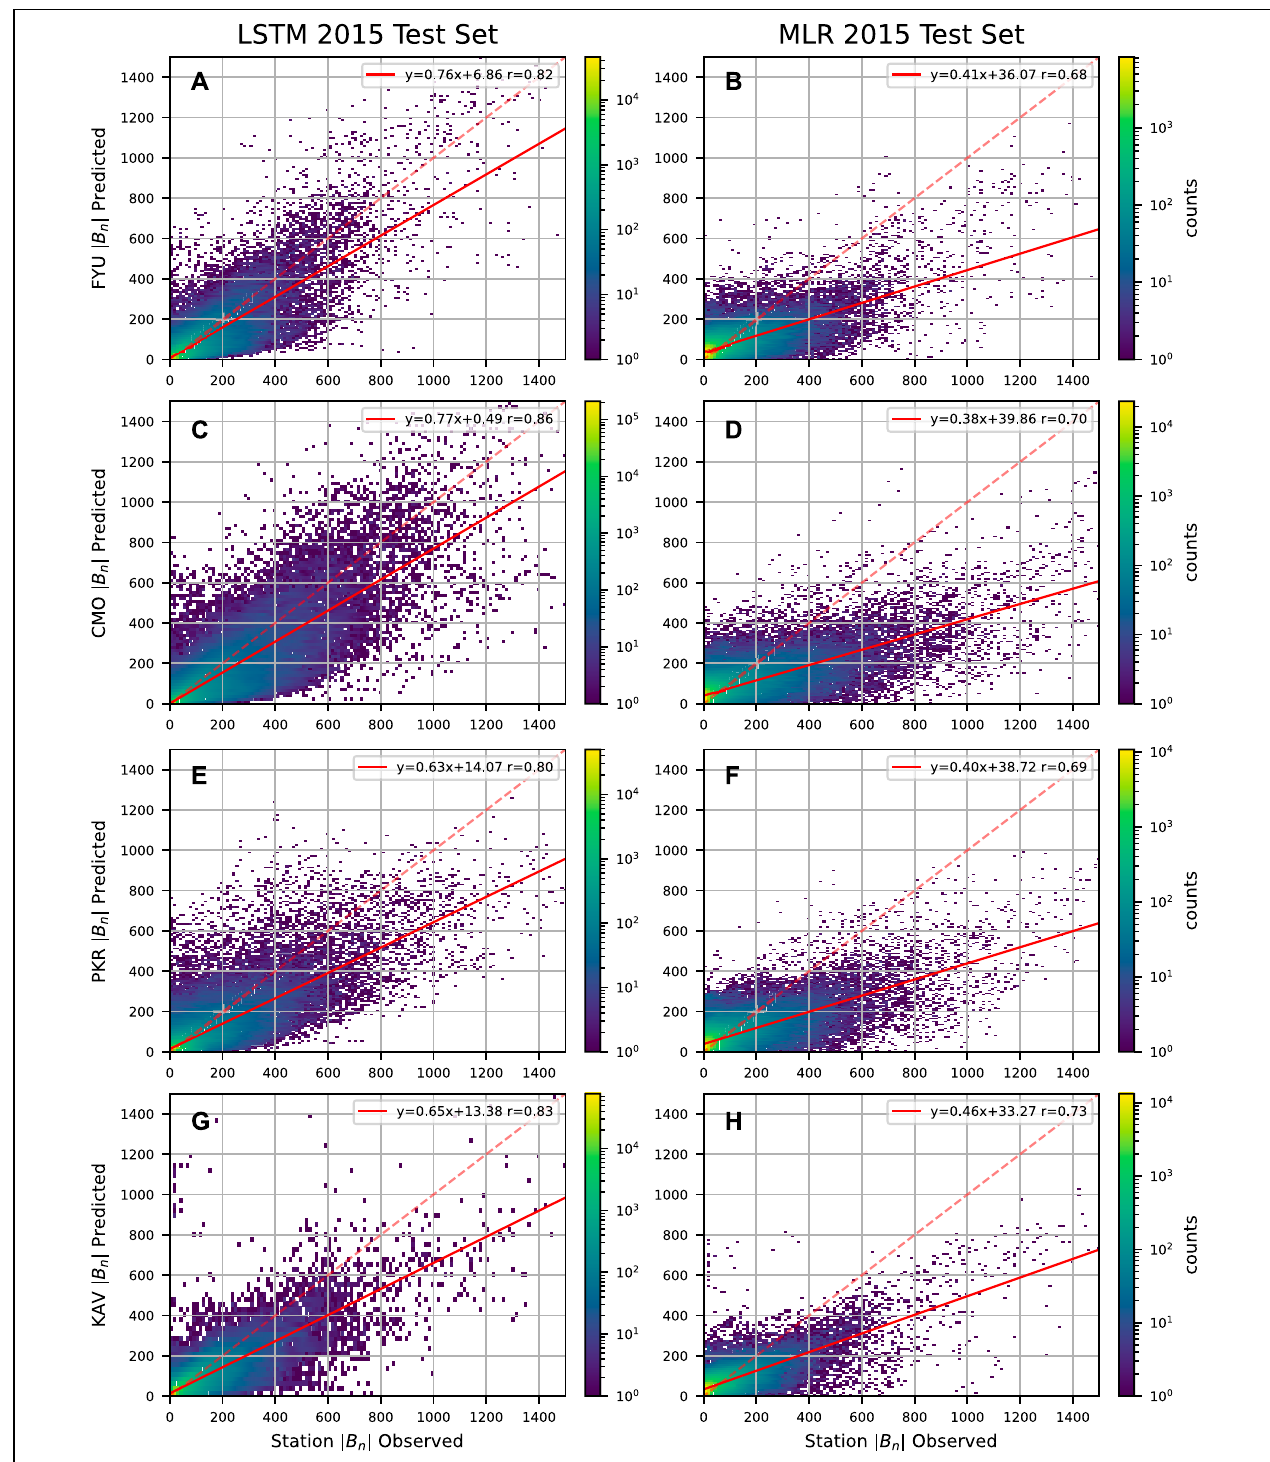
FIGURE 5 | LSTM and MLR density plots using the 2015 test set for all 4 stations. Subplots (A, C, E, G) show prediction results for the LSTM models of each station while subplots (B, D, F, H) show prediction results for the MLR models of each station. Further, we can see that the lines of best fit (solid red) between the LSTM predictions and observed data are much closer to the perfect prediction lines (dashed red) than those of the MLR predictions and the observed data with a 18.2% increase in the average Pearson correlation values.